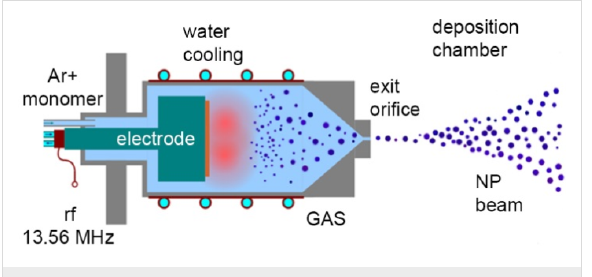
Figure 1: Scheme of a gas aggregation cluster